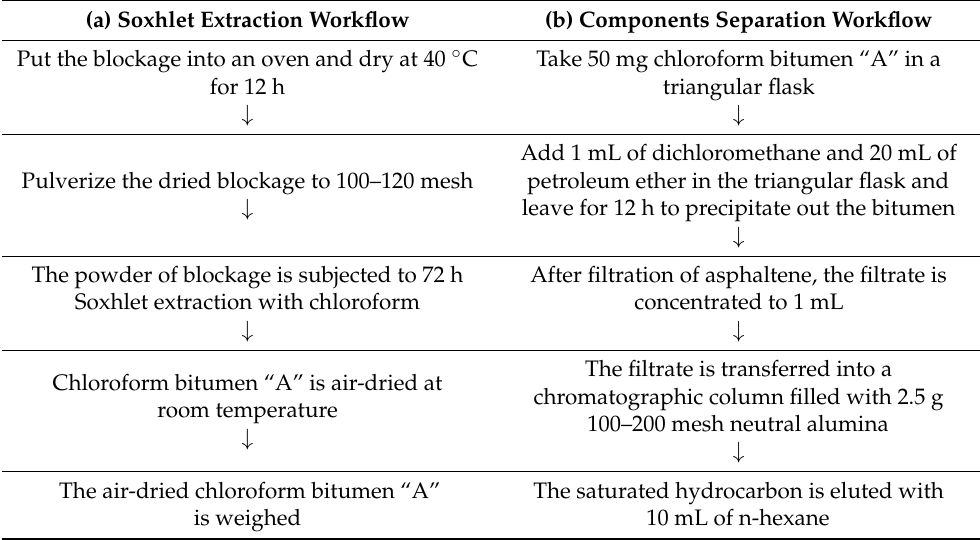
Table 1. The workflow of Soxhlet extraction components’